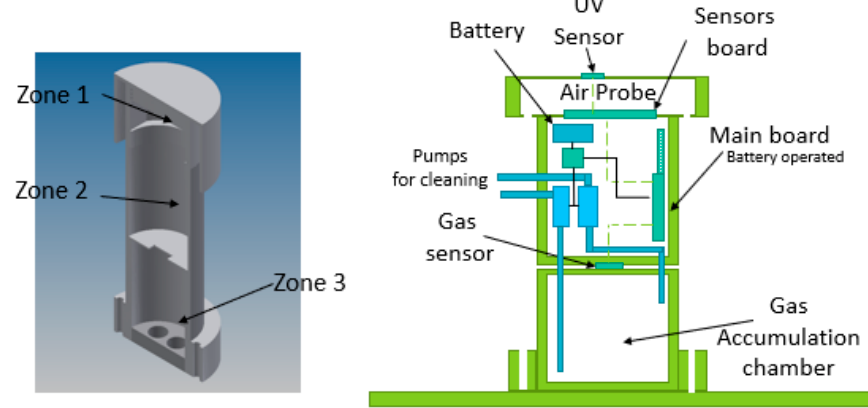
Figure 6. Air probe mechanical Figure 6 . Air probe mechanical architecture .